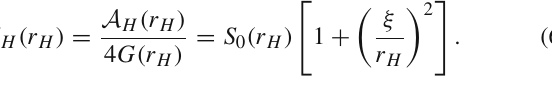
and G 0 = 1. For educative purposes we have rescale T H as follow: ˜ T ˜ T ˜ T (ξ = 0 . 00 ) = 1 . 00 T (ξ = 0 . 15 ) = 1 . 02 T (ξ = 0 . 20 ) = H H , H H , H 1 . 05 T H , ˜ T H (ξ = 0 . 25 ) = 1 . 07 T H , The color code is as follows: (i) black line, for ξ = 0 . 00, (ii) orange line, for ξ = 0 . 15, (iii) cyan line, for ξ = 0 . 20, (iv) red line, for ξ = 0 .